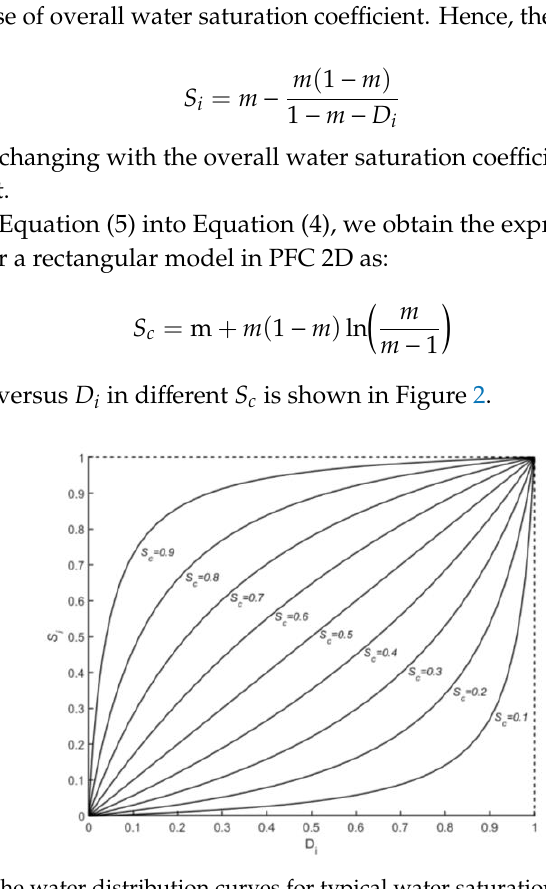
Figure 2. The water distribution curves for typical water saturation coefficient S c.